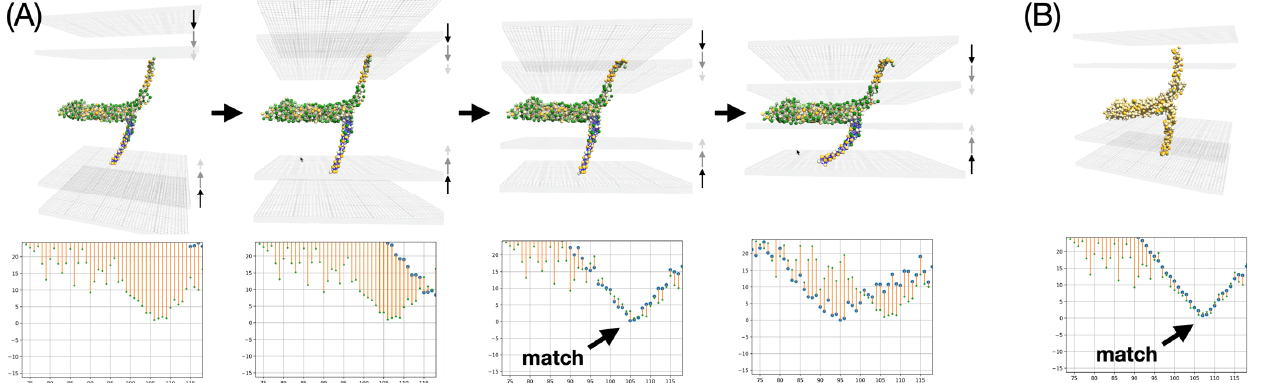
Figure 12. Experiments on the insertion of the SNARE system in double membranes. The four-helical SNARE bundle is represented in the implicit double membrane system delimited by grid lines at the position of the head group regions. The position of one of the TMDs is monitored by interactive representations of the insertion depth in terms of deviations from the reference values obtained by extended MD simulations [4]. The MD values are represented by small green dots, and the actual values in the UNILIPID simulation are represented by blue dots. Red lines highlight the differences between current values and reference MD data. ( A ) shows a series of four snapshots when the membranes are merged using the one bead per amino acid Levitt model representation. It shows good agreement with the reference data as highlighted by a thick black arrow in the third graph. ( B ) shows a similar result on a finer representation with a Martini 3 coarse grained representation. Again, very good agreement with the reference insertion pattern is